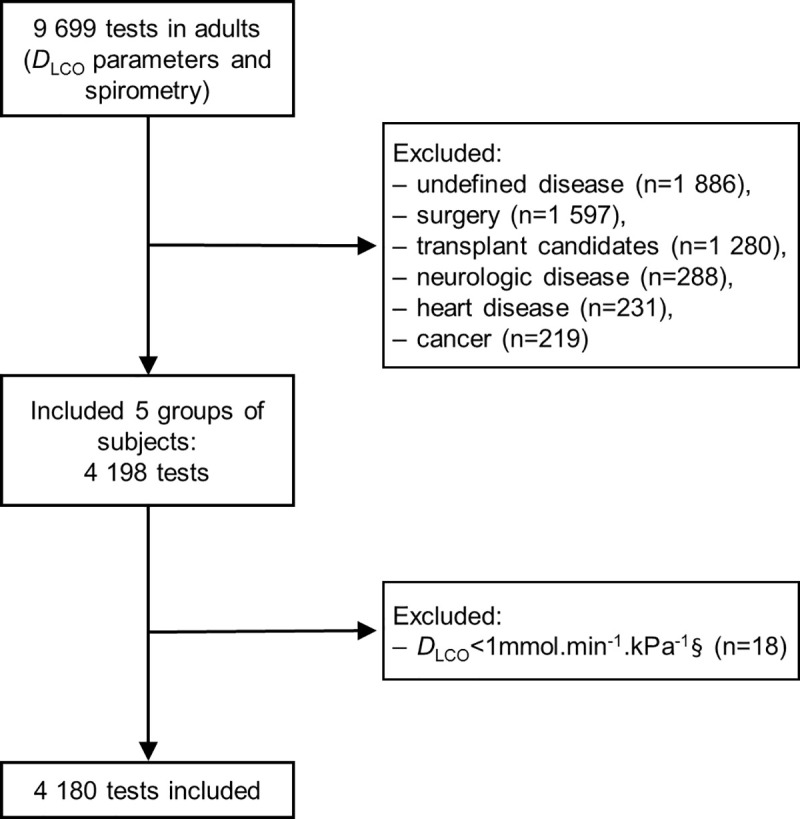
Study flow-chart.DLCO: Diffusing capacity of the lung for carbon monoxide. §: Minimal value for the DLCO predicted value calculation [6,11].